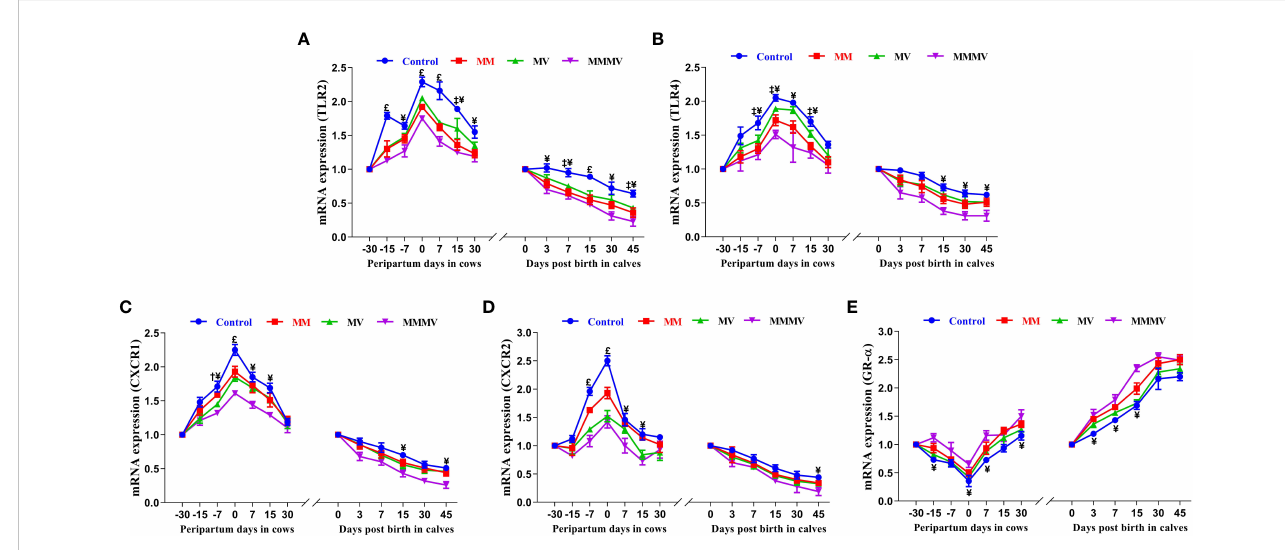
FIGURE 4 Relative mRNA expression of TLR2 (A) , TLR4 (B) , CXCR1 (C) , CXCR2 (D) , and GR- a (E) in blood neutrophils of control and treatment groups of crossbred cattle and their calves. Control: received basal diet only, MM: basal diet + injectable multimineral, MV: basal diet + injectable multivitamins, MMMV: basal diet + combination of injectable multimineral and multivitamins. The mean values with different superscript symbols represent signi fi cant differences with the control group at different days of peripartum in cows and post birth in calves; ‡ Control Vs MM, † Control Vs MV, ¥ Control Vs MMMV. £ Control Vs MM, MV and MMMV. b -actin and GAPDH were used as endogenous genes and the mRNA abundance of the day -30 for cows and day of birth for calves was taken as a calibrator with which relative expression of all genes during different time points was